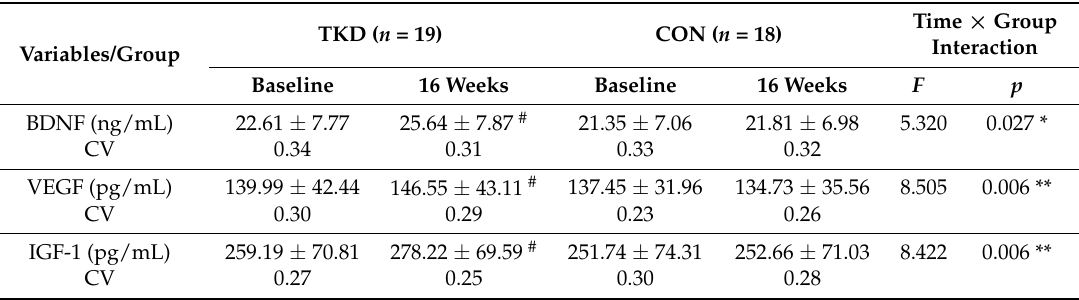
Table 4. Serum levels of the neurotrophic growth factors in the TKD and CON groups before and after the 16-week